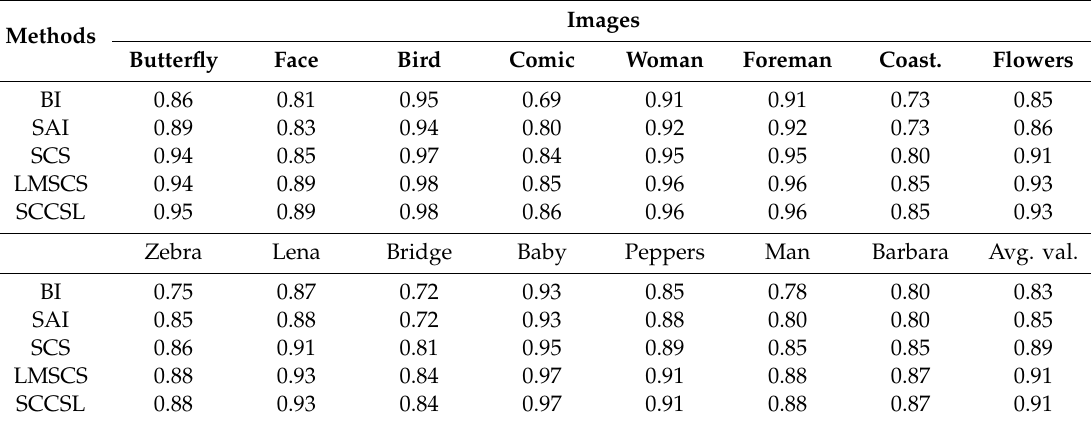
Table 2. The SSIM results of the 15 images by different methods, and bold font indicates that the algorithm has the best SSIM value on a single image.